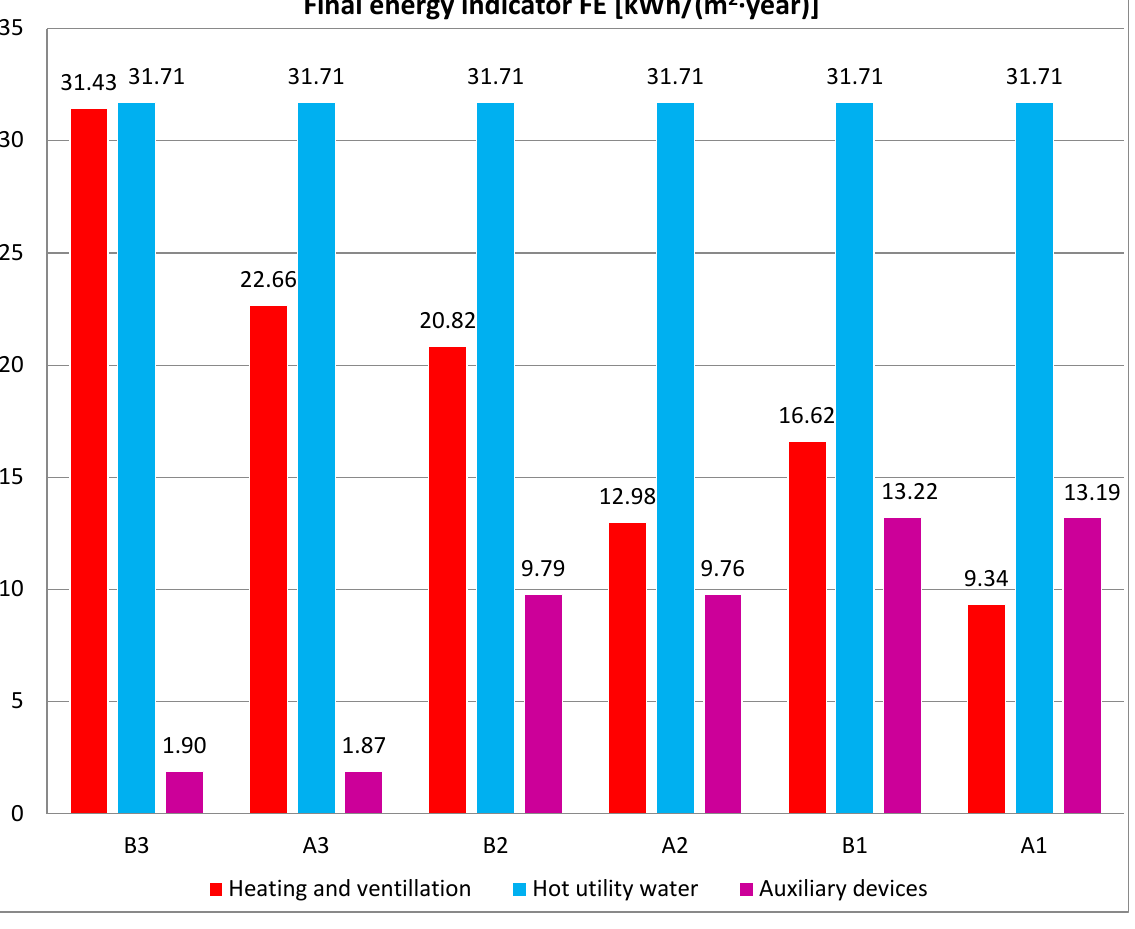
Scheme 4. Comparison of final energy indicators FE for a building of a different energy class for the heat source: the glycol–water heat pump combined with the PV installation.